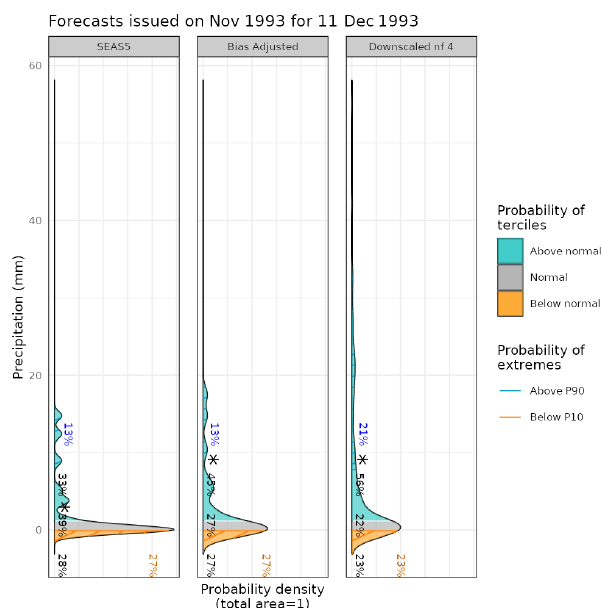
Figure C1. From left to right, the PDF for the original, the bias corrected by quantile mapping, and the downscaled precipitation data (for refinement factor 4) SEAS5 for a grid point corresponding to a observational site in the Alps on 11 December 1993. For each PDF, three categories of equal size are shown, namely terciles above normal (blue), normal (gray), and below normal (orange), defined according to the area average of ERA5 reanalysis for the period 1993–2018. Percentages represent the forecast probabilities of each tercile, the most likely tercile is highlighted with a star, and the blue and orange percentages represent the probabilities for P10 and P90 (hatched areas),